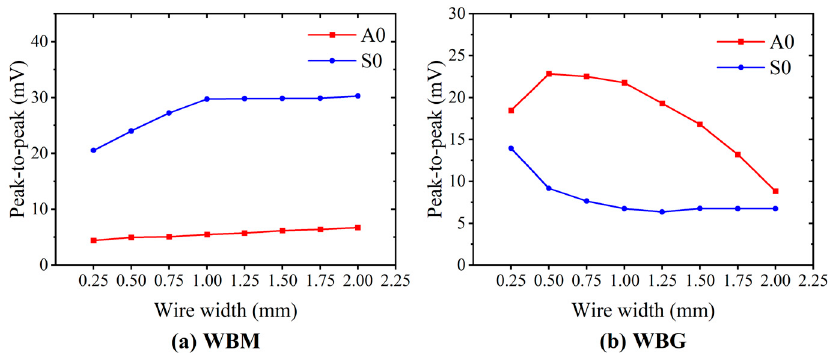
Figure 18. Effect of the wire width on the amplitude of the received signals.